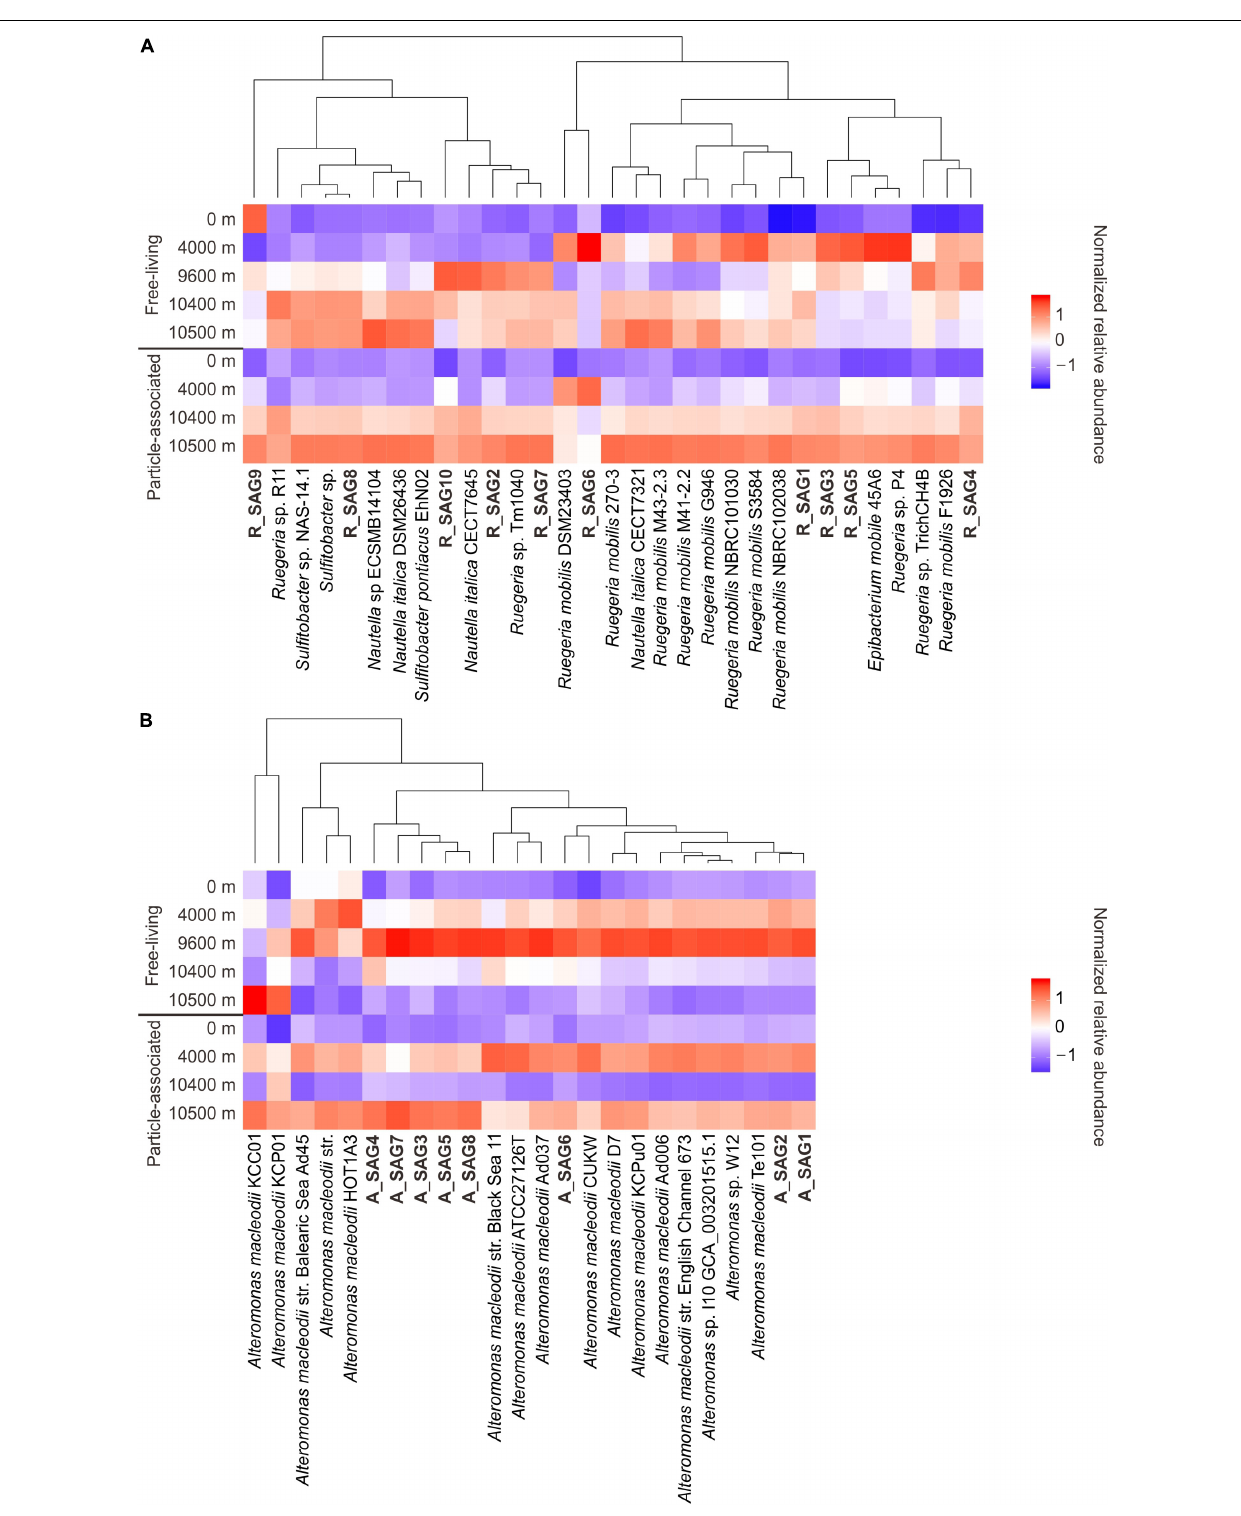
FIGURE 3 | Vertical distribution of (A) the hadal Roseobacter SAGs and (B) the hadal Alteromonas SAGs, along with the closely related reference genomes. Distribution is based on genomic recruitment against the metagenomes of free-living and particle-associated microbial assemblages from the surface to depths of the Mariana Trench (Liu et al., 2019). For each size fraction, the normalized relative abundance (RPKG value) of each genome (see Methods) along depth profile was Z -normalized (Magalhães et al., 2008) for a clearly visible display. The SAGs from this study are shown in bold.